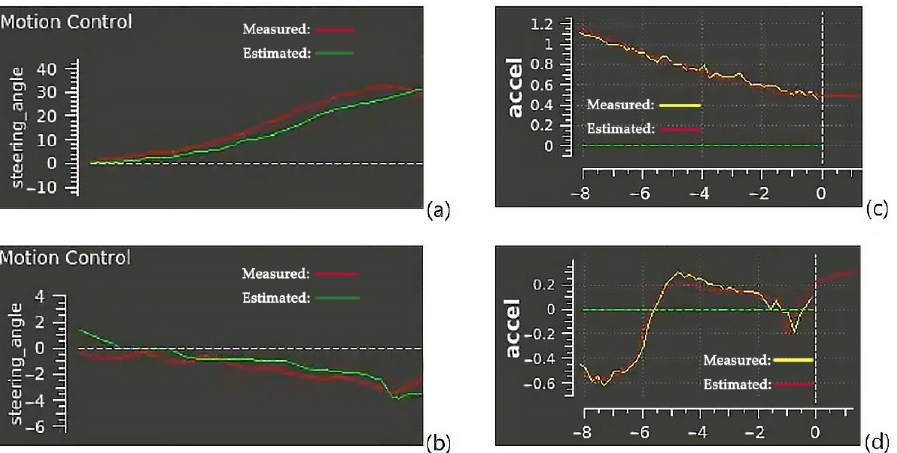
Figure 7. State monitoring and estimation: ( a ) steering angle with large amplitude, ( b ) steering angle with small amplitude, ( c ) longitudinal acceleration with large amplitude, ( d ) longitudinal acceleration with small amplitude.